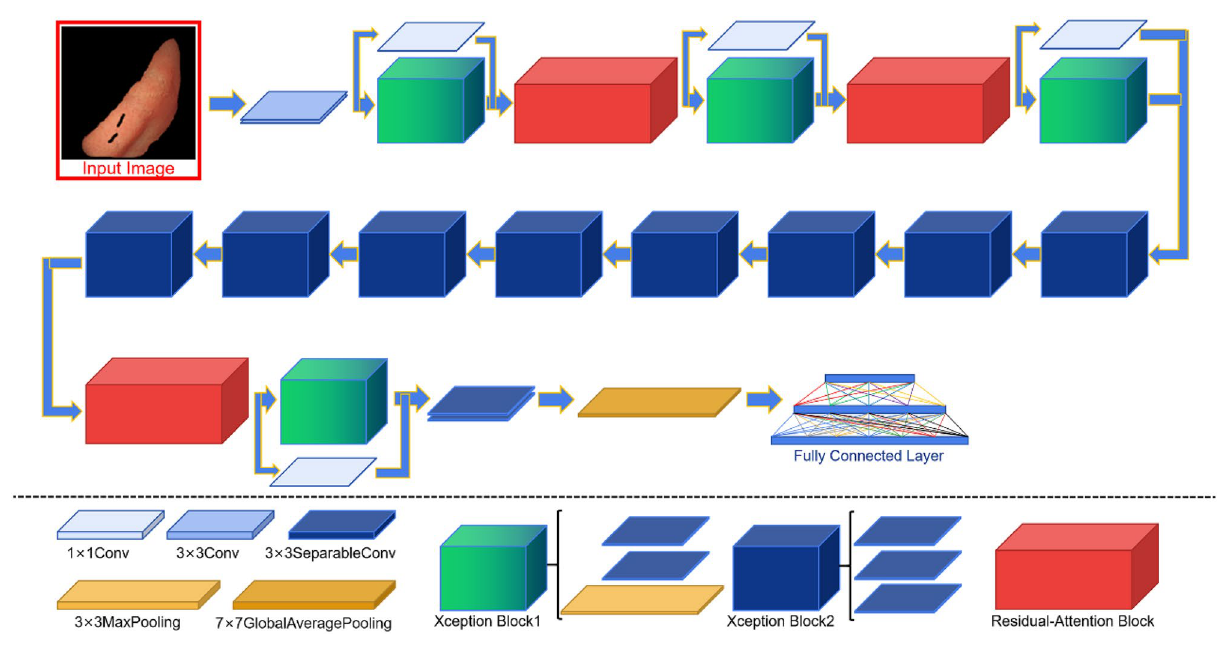
Figure 5. The overall network